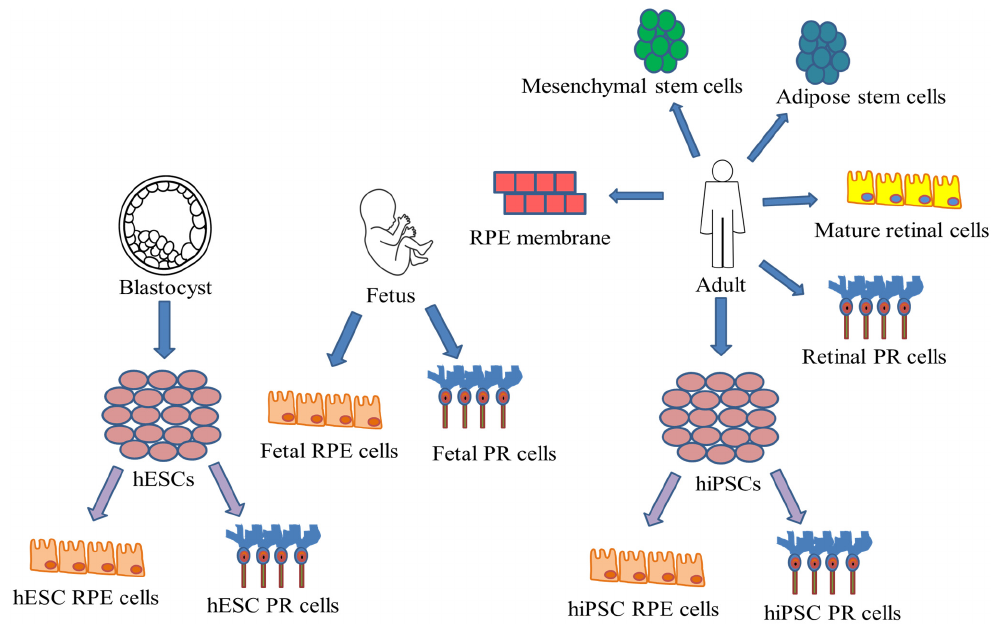
Figure 6. Schematic representation of cell sources for the cell therapy of retinal degenerative diseases.